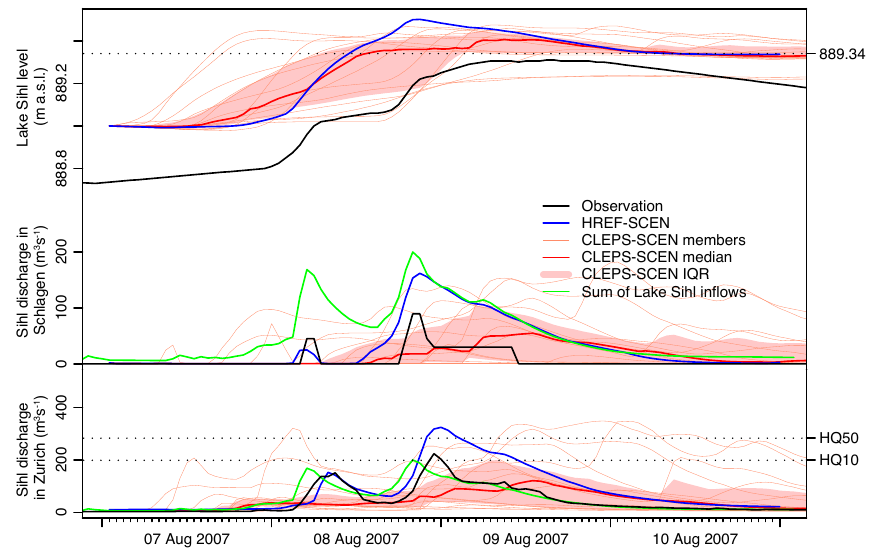
Fig. 10. Lake Sihl level (top), water released at the dam outlet (Schlagen, centre) and discharge in Zurich (bottom) for an artificially increased Lake Sihl level of 889ma.s.l. on 7 August 2007 at 00:00UTC. Dotted lines indicate the altitude of the dam operation limit (889.34ma.s.l., top plot) and the discharges associated with return periods of 10 and 50 years (HQ10 and HQ50, bottom